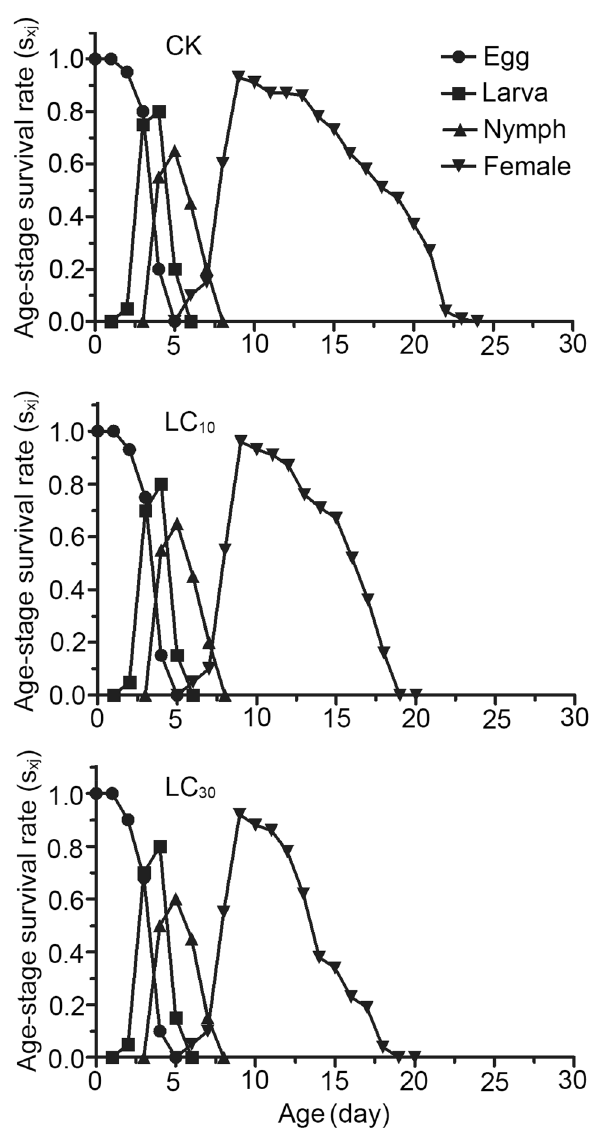
Figure 2. Age-stage specific s rate ( s xj ) of Panonychus citri. After exposure to low lethal concentrations of